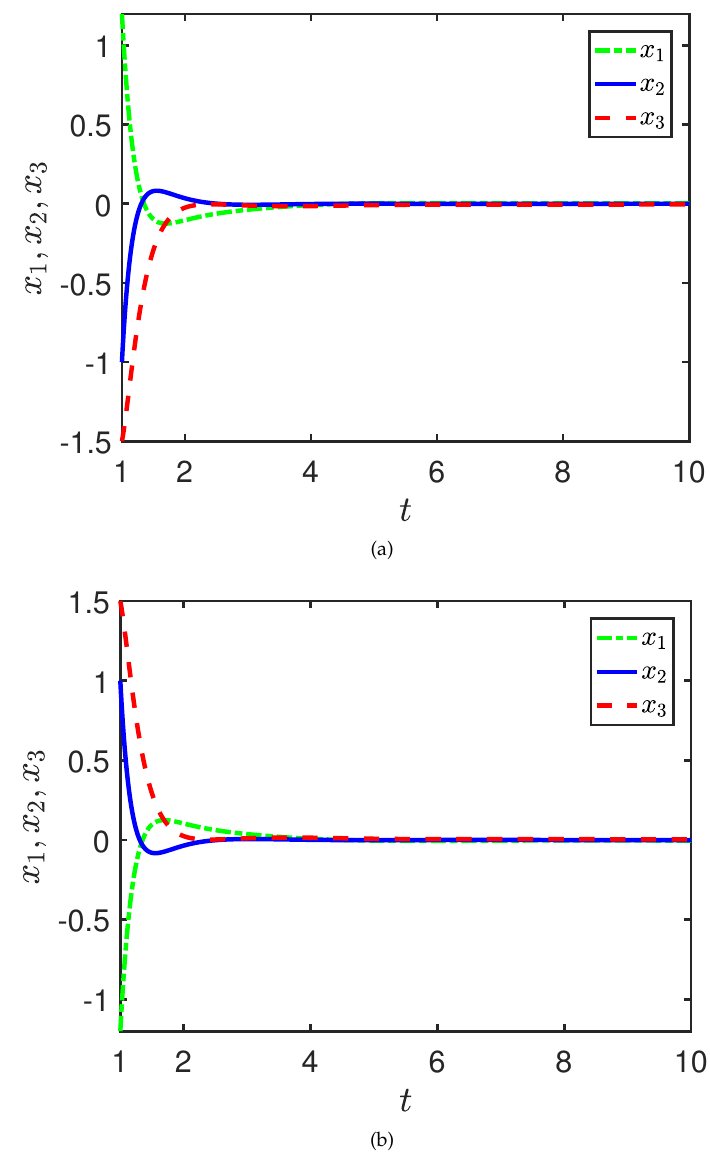
Figure 2. The evolution of system (76). ( a ) x ( 1 ) = ( 1.2, − 1, − 1.5 ) T ; ( b ) x ( 1 ) = ( − 1.2,1,1.5 ) T